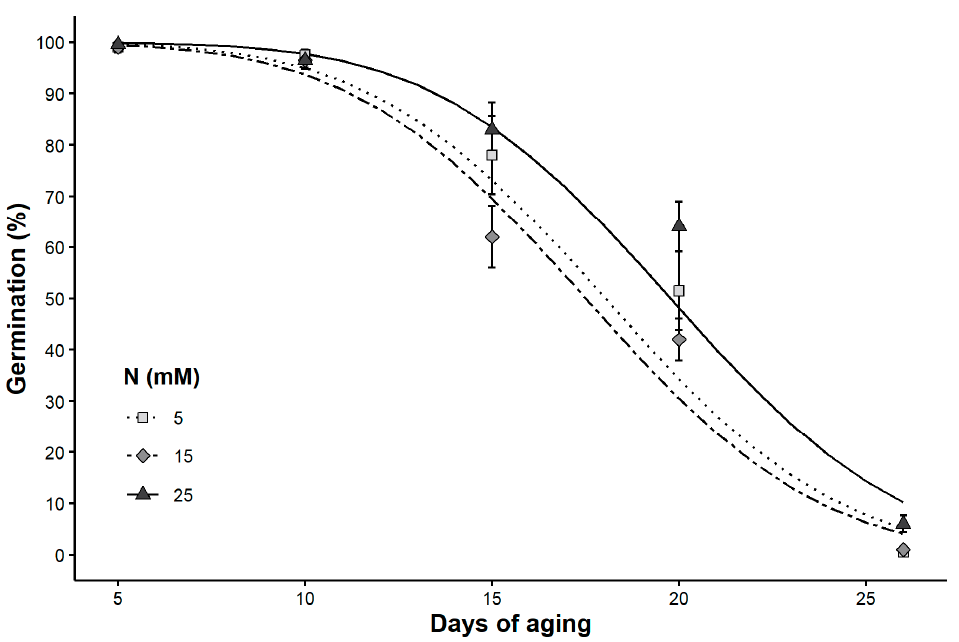
Figure 6. Germination after different periods of accelerated aging (41 ◦ C and 96% RH) of seeds from tomato plants fertigated with solutions of 5, 15 or 25 mM nitrogen (N) concentration. Data are an average of four replicates of 50 seeds each and bars represent its standard error. Aging curves were fitted by probit analysis of the data, according with Equation (3), with a common standard deviation ( σ ) of 4,89 days and Ki values of 3.69, 3.58, and 4.04 for seeds from the 5, 15, and 25 mM N treatments, respectively.